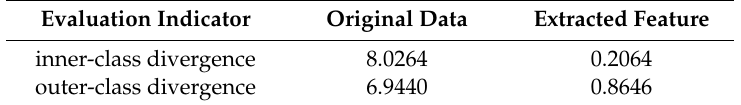
Table 2. The total inner and outer class divergence of the Original data and the Extracted